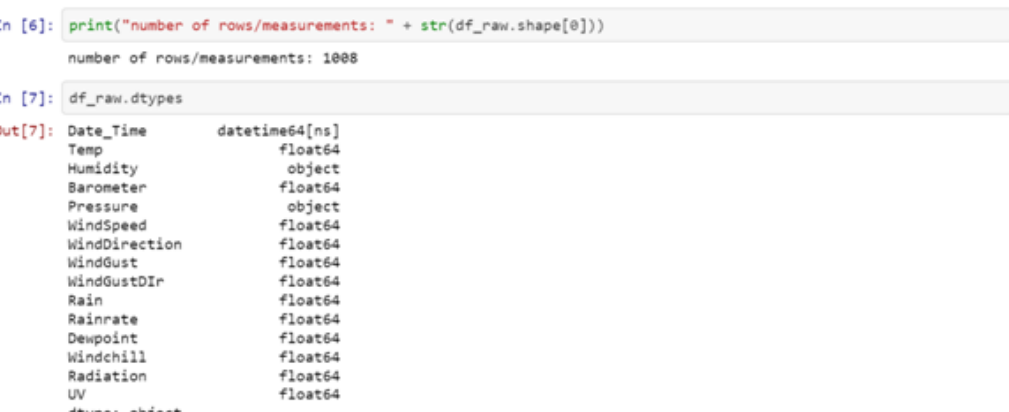
Figure A2. Summarized algorithm report - Excerpt